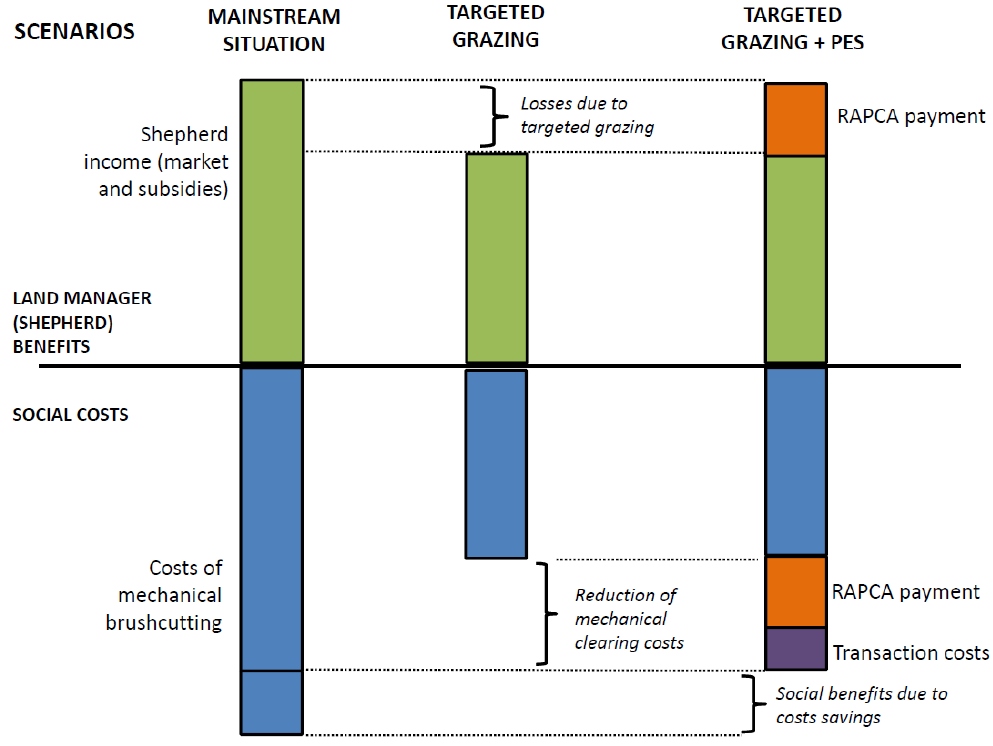
Figure 1. Land manager benefits and social costs in three scenarios: with no fire prevention, fire prevention with targeted grazing, and targeted grazing remunerated service. Source: own elaboration based on Engel et al. [93].